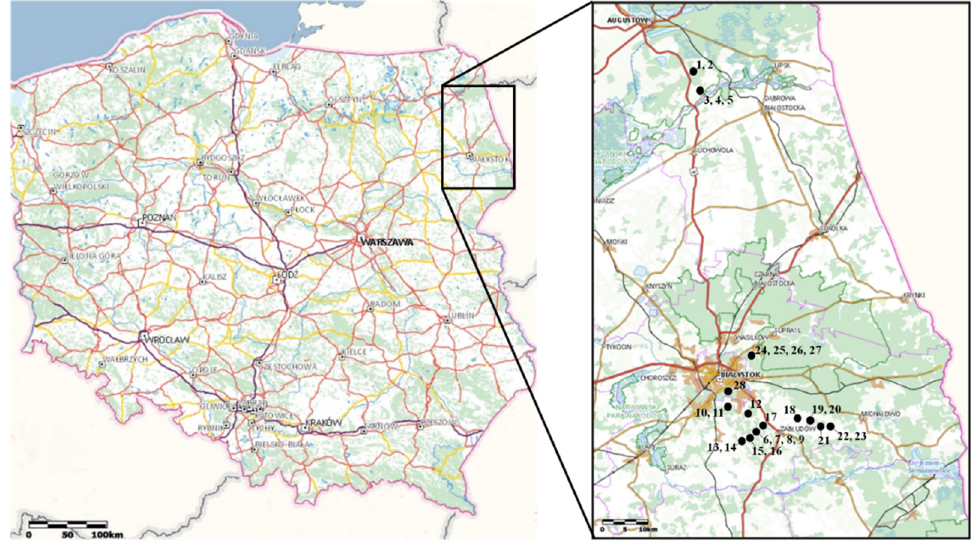
Figure 1. Map of the studied 28 wells in north-eastern Poland. Numbers 1–28 are according to Table 1. Table 1. The list of studied wells with GPS locations, the total number of copepods, and the Copepoda species ( Es — Eucyclops serrulatus ; Db — Diacyclops bisetosus ; Dc — Diacyclops crassicaudis ; Eg — Eudiaptomus gracilis ; Tc — Thermocyclops crassus ).